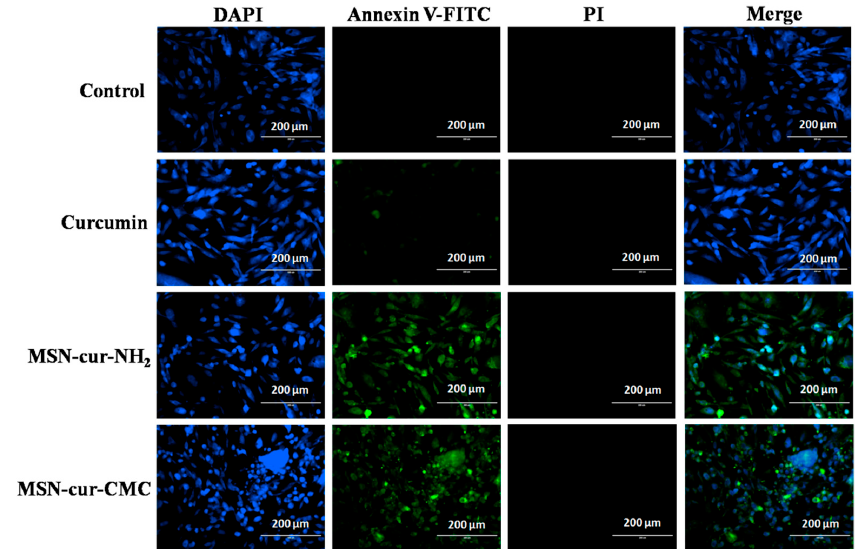
Figure 8. Apoptosis of MDA-MB-231 cells using fluorescence microscopy. Images of MDA-MB-231